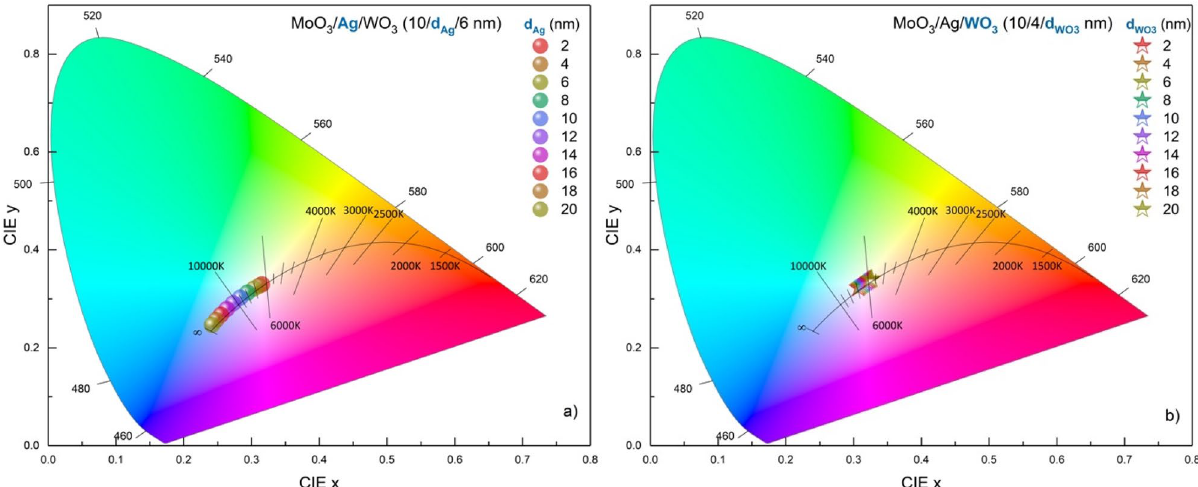
Figure 5. Colour coordinates of the transparent contact structure. In CIE 1931 Chromacity diagram, representation of colour coordinate changes corresponding to d Ag of MoO 3 /Ag/WO 3 (10/ d Ag /6 nm) transparent contact structure. The black line in the diagrams shows the Planckian locus values for different CCTs. In the colour coordinates of the contact, a blue shift on the Planckian locus occurs with the d Ag